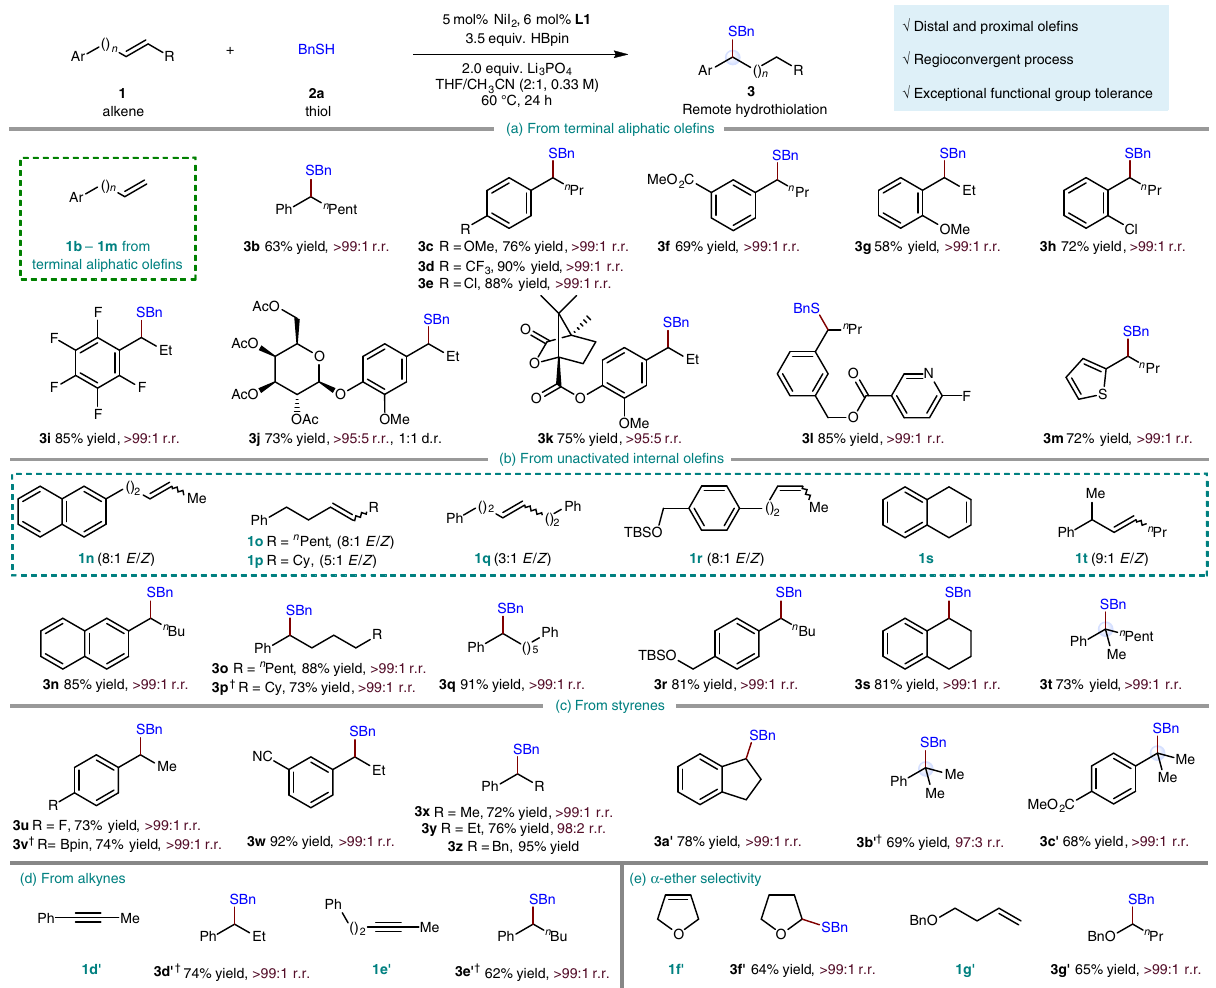
Fig. 3 Substrate scope of alkene component. Under each product are given yield in percent, and regioisomeric ratio (r.r.). Yield refers to isolated yield of puri fi ed product (0.20 mmol scale, average of two experiments). r.r. represents the ratio of the major product to the sum of all other isomers as determined by gas chromatography (GC) analysis, ratios reported as >95:5 were determined by crude proton nuclear magnetic resonance ( 1 H NMR) analysis. † Forty eight hours. Me, methyl; Et, ethyl; n Bu, n -butyl; n Pent, n -pentyl; Cy, cyclohexyl; TBS, tert -butyldimethylsilyl NATURE COMMUNICATIONS| (2019) 10:1752